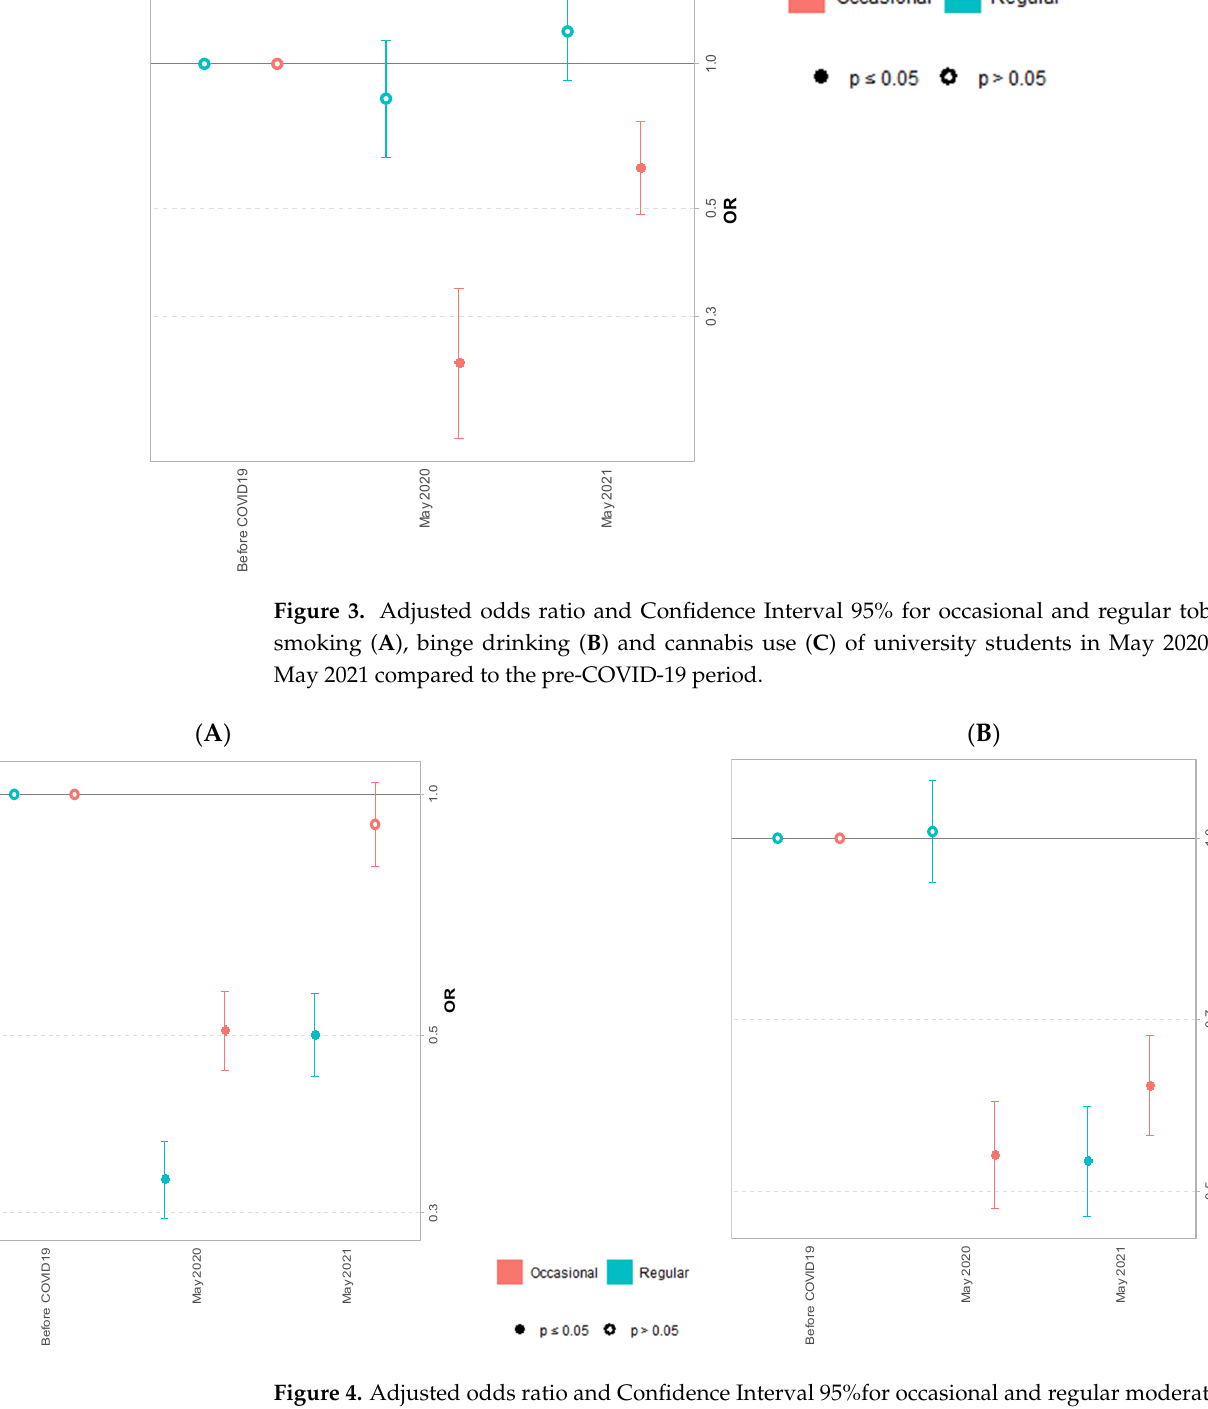
Figure 4. Adjusted odds ratio and Confidence Interval 95%for occasional and regular moderate ( A